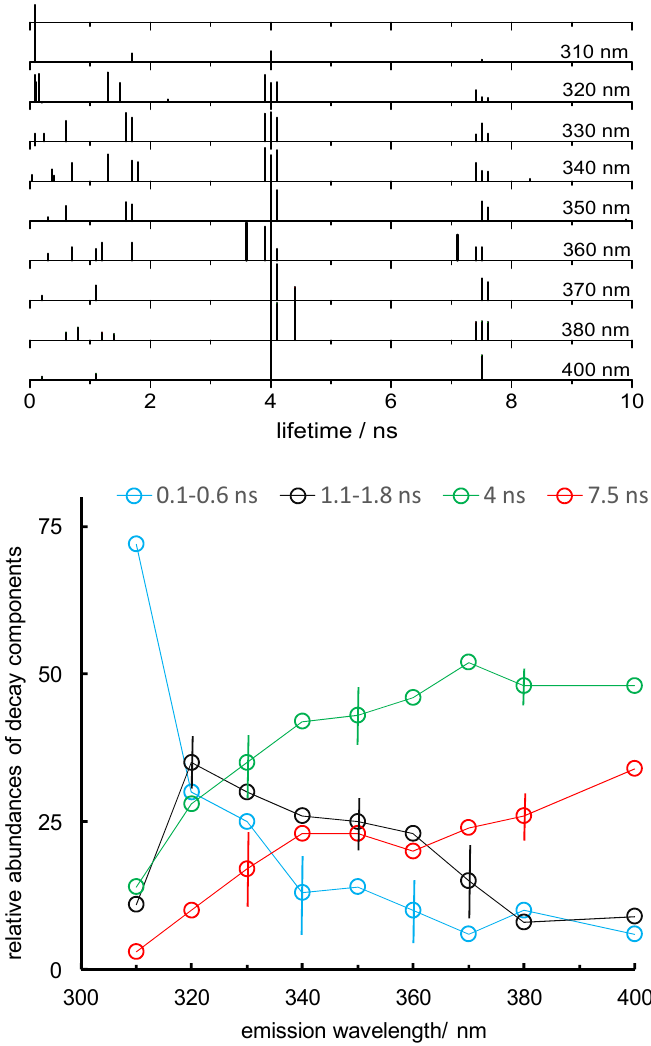
Figure 4. Lifetime profile of Lm PTR1. Top: schematic representation of the exponential components of emission decays of Lm PTR1 obtained at the given emission wavelengths of the decay measurement and analysis (the results of two-to-four repetitions, one at 310 and 400 nm, are shown). Each segment represents a component lifetime in the analysis of the emission decay, and its height the relative component abundance. Bottom: average relative abundances (expressed as %) of the four components in the emission decay of Lm PTR1 as functions of emission wavelengths. Vertical bars correspond to ± standard deviations of four to six abundance values. λ exc = 285 nm.